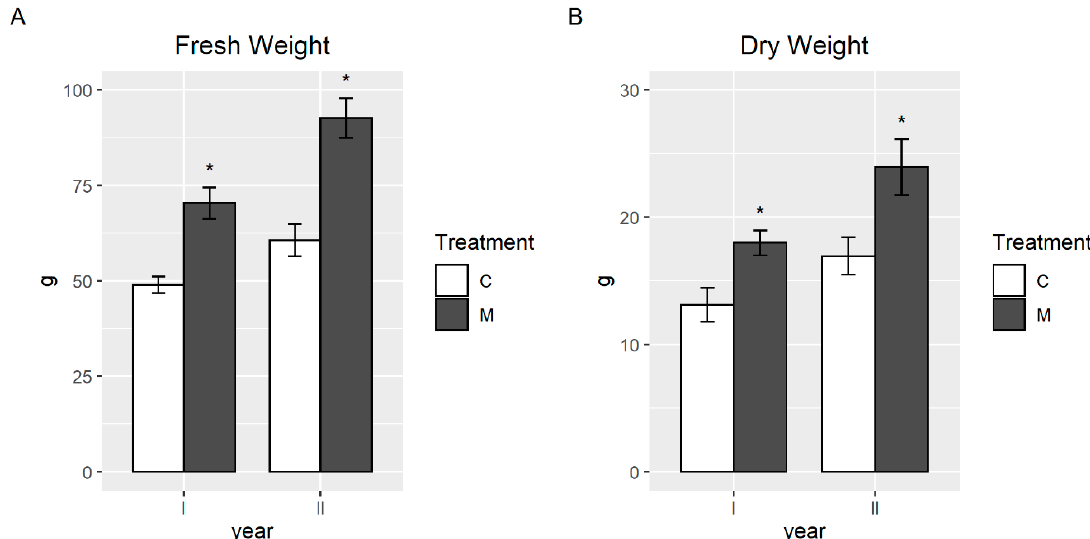
Figure 1. Average fresh ( A ) and dry weight ( B ) of aerial parts of P. vittata plants, inoculated (M) or not (C) with a mixture of arbuscular mycorrhizal fungi (AMF), in the pot experiment. The Asterisk (‘*’) indicates that the differences among the treatments in the same year were significant ( p -value < 0.05). Error bars indicate standard errors.